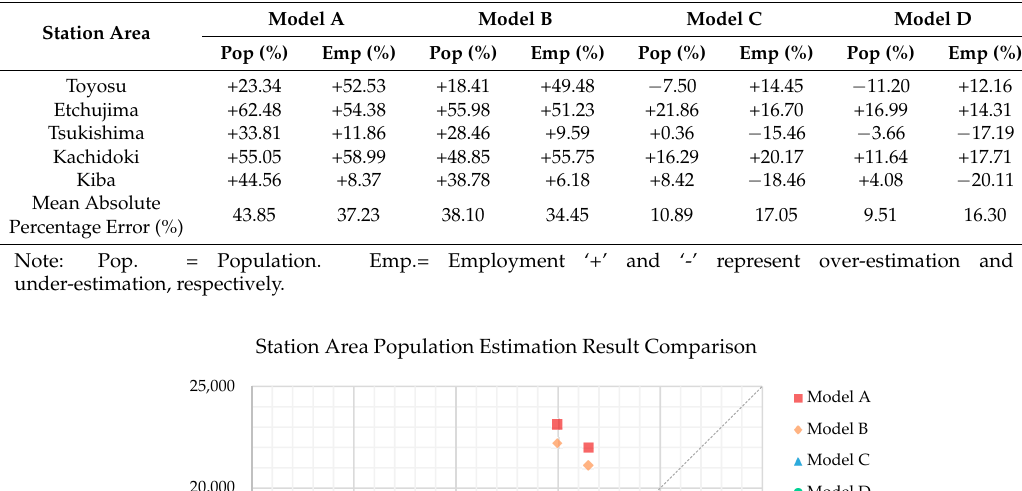
Table 6. Tokyo’s five station areas’ population and employment estimation accuracy assessment results.